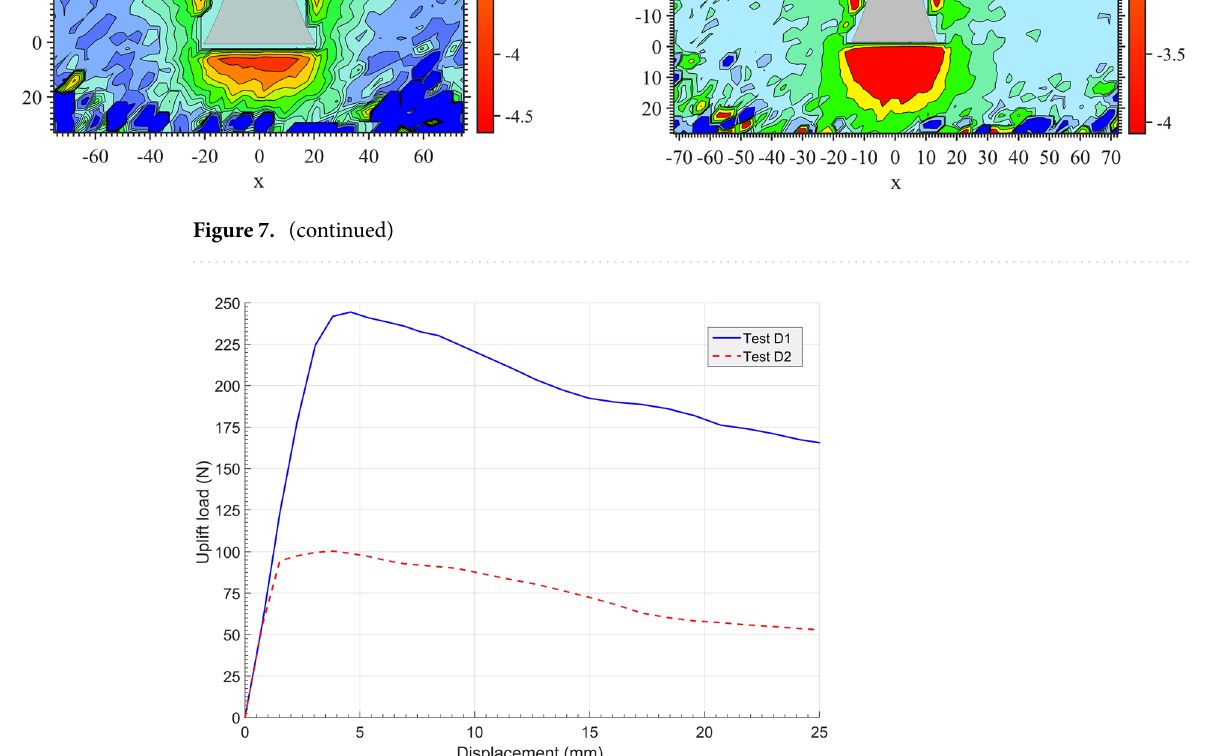
Figure 8. Uplift load–displacement curves of soil anchors.